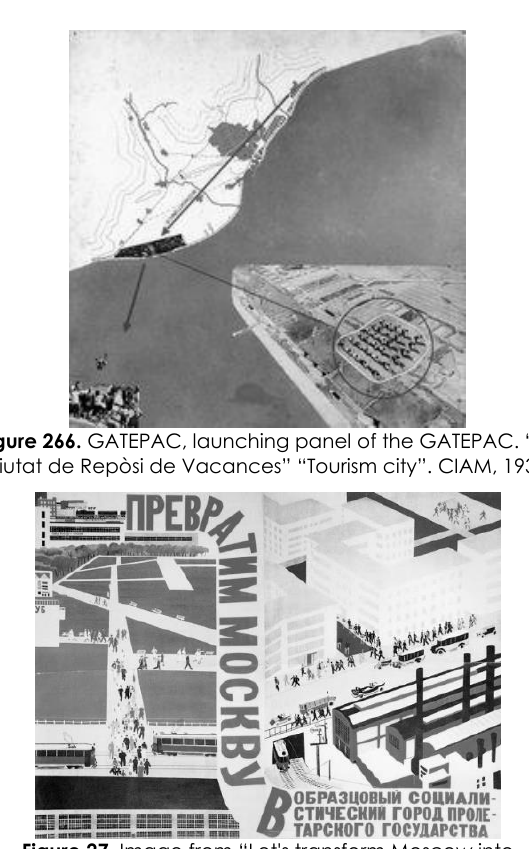
Figure 27. Image from “Let's transform Moscow into exemplary socialist city of the proletarian state” by AleksandrDejneka,